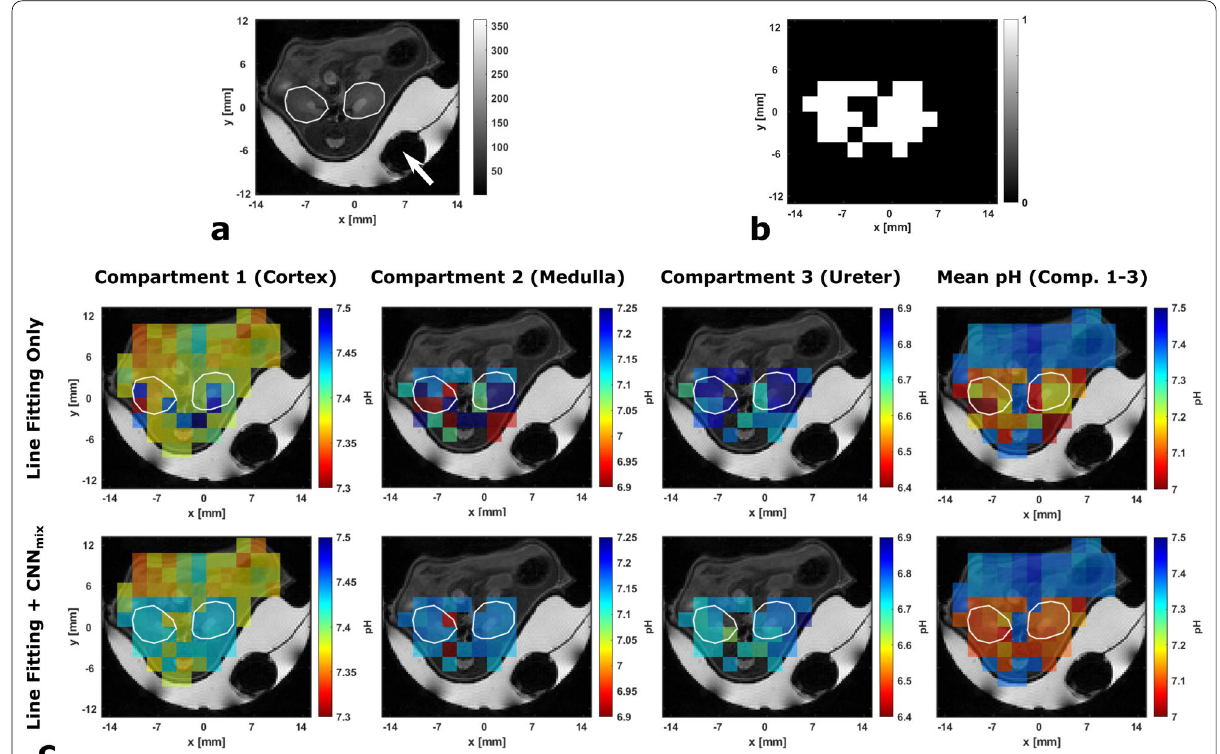
Fig. 7 a Anatomical axial T 2 ‑weighted image of mice kidney encircled with white ROIs. For shim improvements, the mouse, as well as a [1‑ 13 C]lactate‑phantom for B 1 calibration are covered with carbomer gel. b Segmentation mask for a 14 12 CSI data sets acquired on the anatomy × in a . White areas indicate voxels corresponding to spectra with three pH compartments, black areas indicate voxels of which spectra contain two or less compartments. c Top row: Individual pH compartment maps for the cortex or a physiological pH compartment (compartment 1), a slightly acidified compartment, mainly the medulla (compartment 2) and a strongly acidified compartment of the ureter (compartment 3) as derived from supervised line fitting. The mean pH map represents the un‑weighted average of all three pH compartment maps. Bottom row: Compartment maps derived from line fitting where white areas in the segmentation mask have been replaced by voxel‑wise predicted pH values from CNN mix . The mean pH map displays the average pH value of the respective number of pH